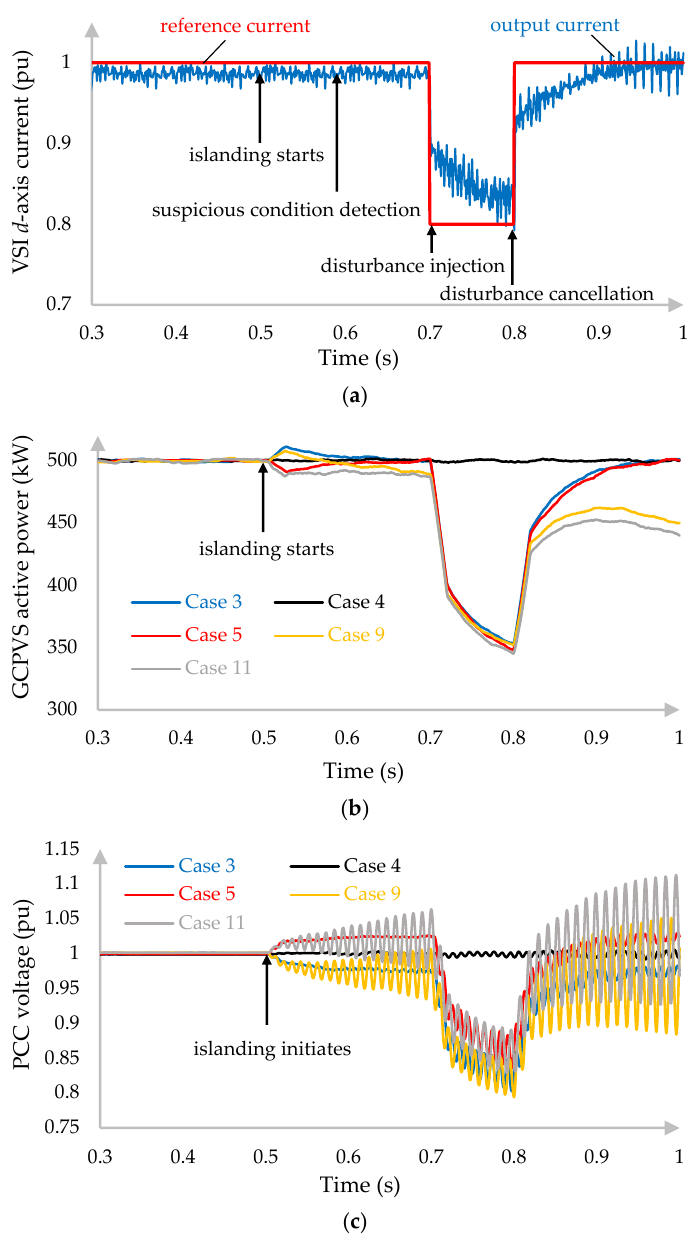
Figure 6. Outputs of active and reactive power mismatches islanding scenarios: ( a ) Reference and output current (case 3 only); ( b ) GCPVS active power; ( c ) PCC voltage.